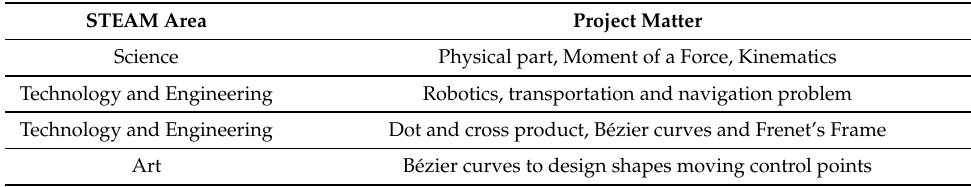
Table 3. STEAM concepts in the transportation